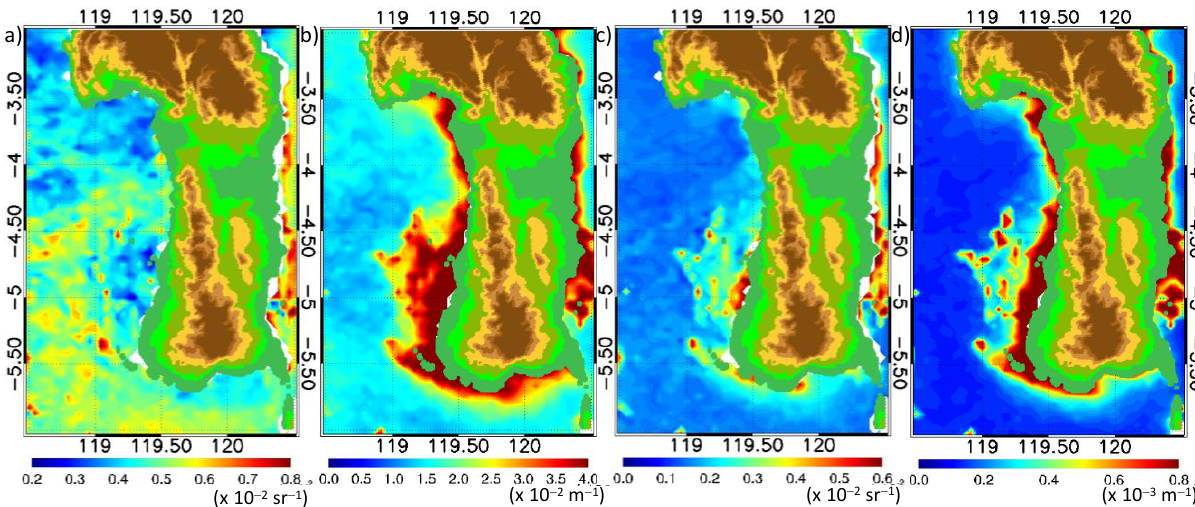
Figure 5. The spatial distribution of ( a ) Rrs 443, ( b ) aph 443, ( c ) Rrs 555, and ( d ) bbp 555 along the western coast of South Sulawesi in January climatology (2007 – 2019). Lower Rrs 443 and higher aph 443 denote the existence of phytoplankton, while higher Rrs 555 and higher bbp 555 denote the existence of suspended sediment.